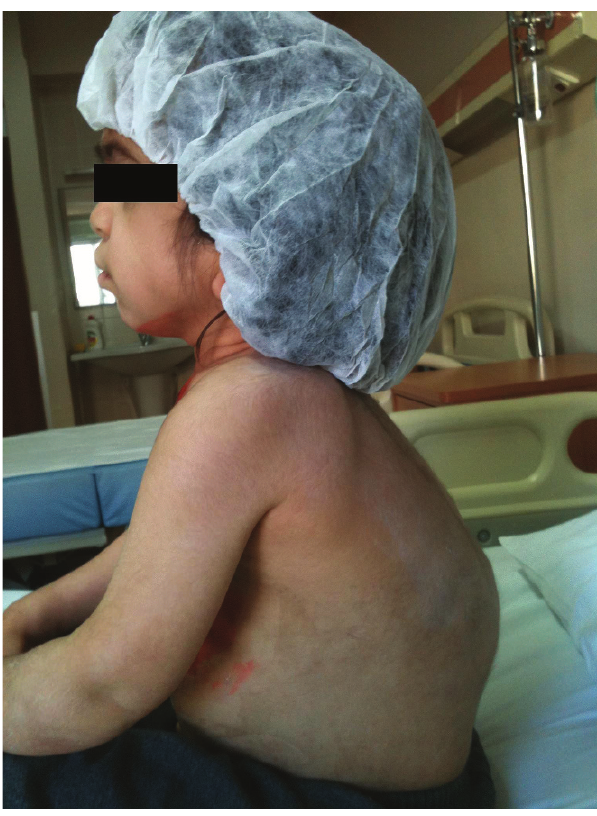
Figure 1 - Lateral position showing kyphoscoliosis and short stature.